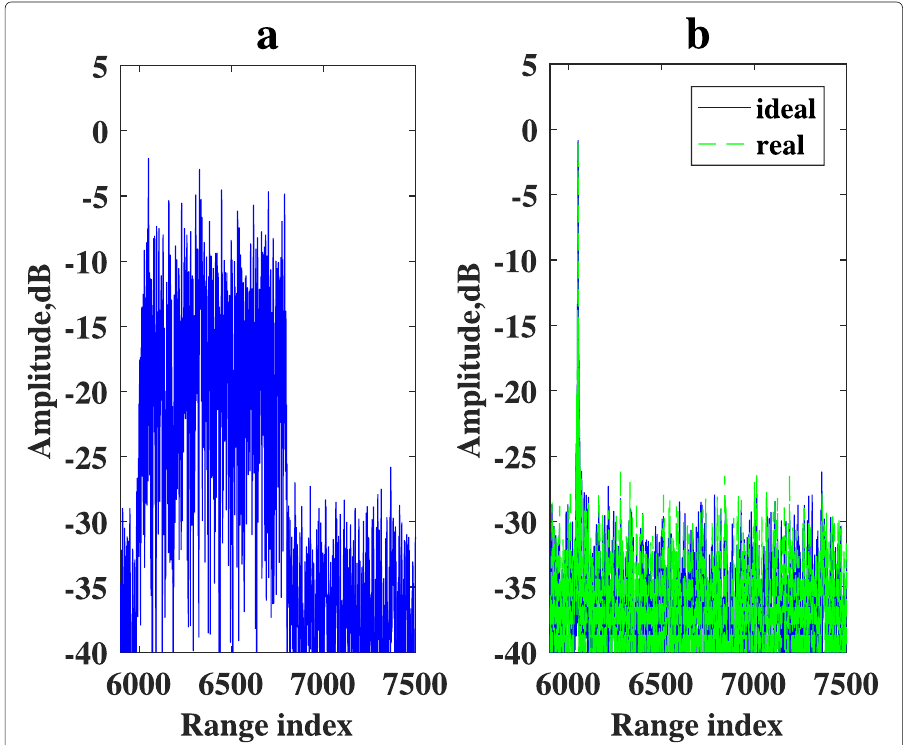
Fig. 3 Contrast between the traditional PC and the proposed algorithm to suppress jamming in the CNJ scenario. (SNR = 5 dB, JNR = 15 dB). a Traditional PC. b The proposed